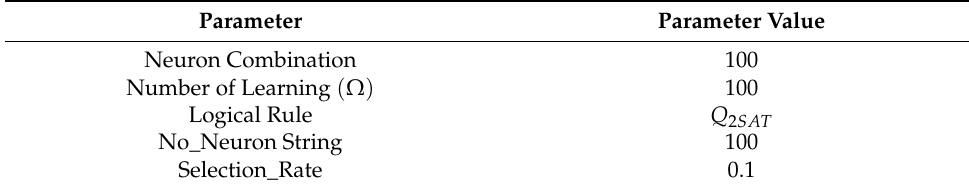
Table 8. Improved RA